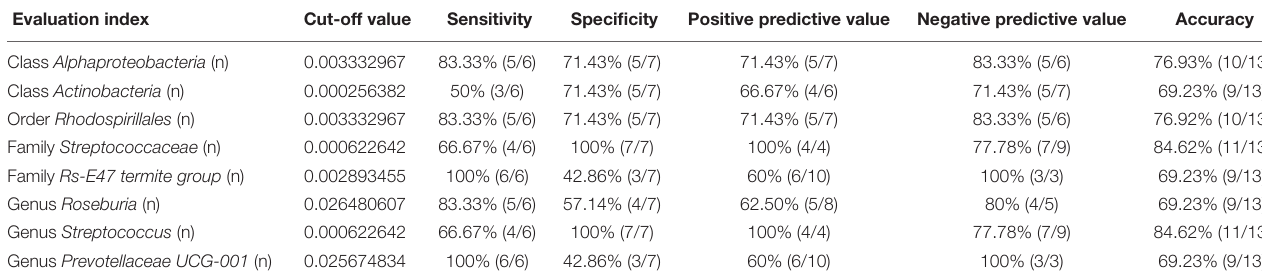
FIGURE 7 | ROC curves of various gut microbiota for the depression-like behavior phenotypes of CMI rats. Class Alphaproteobacteria (AUC = 0.810). Class Actinobacteria (AUC = 0.536). Order Rhodospirillales (AUC = 0.798). Family Streptococcaceae (AUC = 0.857). Family Rs-E47_termite_group (AUC = 0.714). Genus Roseburia (AUC = 0.702). Genus Streptococcus (AUC = 0.667). Genus Prevotellaceae_UCG-001 (AUC = 0.667). ROC, receiver operating characteristic; AUC, area under the curve. TABLE 1 | Evaluation of various gut microbiota for diagnosis of depression-like